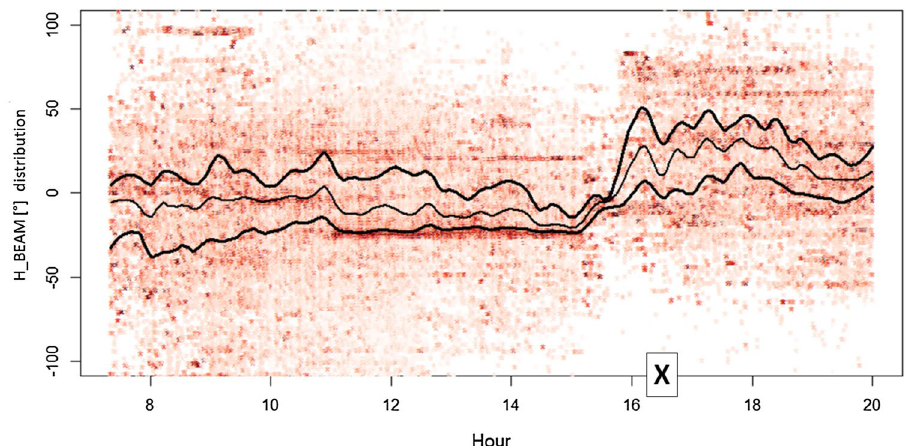
Figure 6. Angular distribution of measures around the direction of maximum power for BS cells Sun oriented during July 3rd. Lines identify the distribution median (the central line) and +/− standard deviation (color saturation reflects the density of cases). “X” indicates the flare peak in X-ray emission (local Italian time, UT + 2H). The loose of balance (distribution squeezing and bending) approaching “X” depends also on two contingency reasons: a sudden decrease of the number of measures for the Sun exposed BS cells and BS cells azimuths not perfectly distributed along all possible 0°–359° angles.